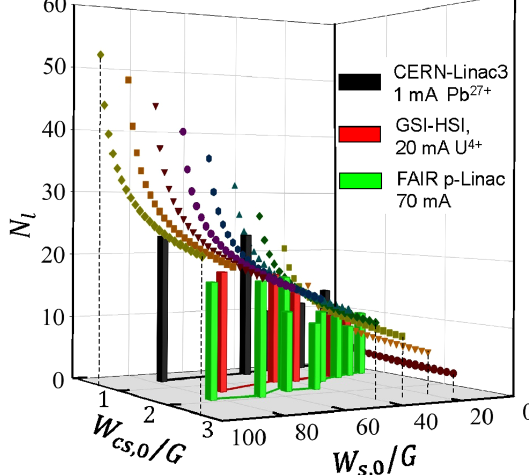
FIG. 11. Illustration of the N l dependence on W s; 0 =G and on W =G . Symbols describe the N cs; 0 l values resulting from Eq. (17) for identical W s; 0 =G ratios of 10 ; 20 ; … 100 , while bars indicate N l values of linac layouts, which are in operation (CERN linac3, GSI high-current injector HSI) or under construction (FAIR p-linac), respectively.